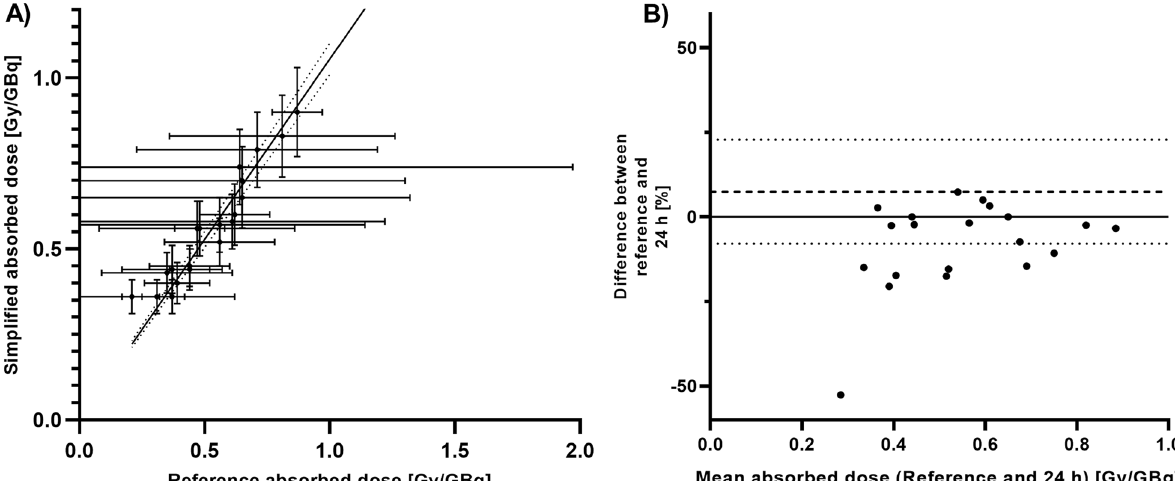
Fig. 3 Results of organ dosimetry based on a single SPECT at 24 h compared to the reference standard for kidneys. A concordance between the absorbed dose according to the new method ( y -axis) and the reference standard ( x -axis). The diagonal line is the line of perfect concordance. B Bland–Altman plot showing the mean difference between both methods as a function of the mean absorbed dose of both methods. The upper and lower dashed lines indicate the limits of agreement